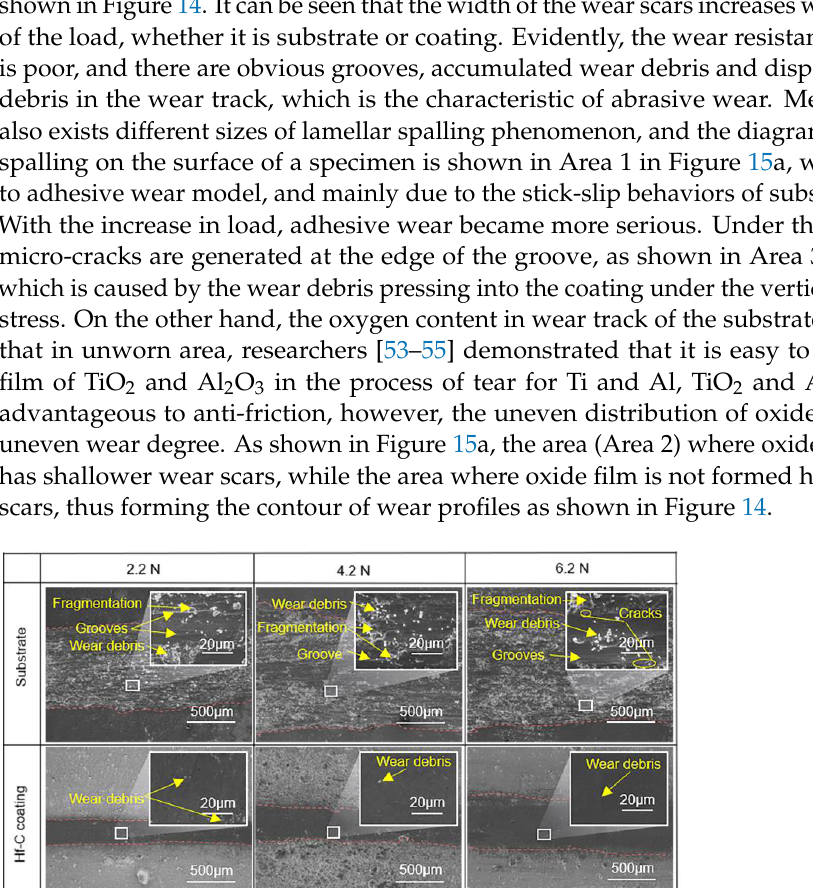
Figure 15. Wear mechanism diagram of ( a ) Substrate and ( b ) Coatings; crystal structure of ( c ) HfC and ( d ) Hf 0.5 Ta 0.5 C; ( e ) Change of bond length. The wear behavior of the two coatings is similar. Although the graphite on the sur- face plays a role of lubrication to make the wear process stable, the wear rate increases with the increase of load. The wear mechanisms of the two coatings are both abrasive wear. However, the wear rates of HfTaC 2 coatings are always less than HfC coatings. And cross section profiles of wear scars of HfC coatings are roughly V-shaped, while that of HfTaC 2 coatings is roughly U-shaped. These differences are attributed to the solid solution strengthening of tantalum doping hafnium carbide. Tantalum doping increases the ani- sotropy of mechanical properties, as shown in Figures 6 and 7. It can be speculated that the anisotropy of crystal also increases. The crystal structure of tantalum doped hafnium carbide was simulated by first-principles calculation, and the crystal structure of Ta- doped hafnium carbide lattice was simulated by random substitution model, as shown in